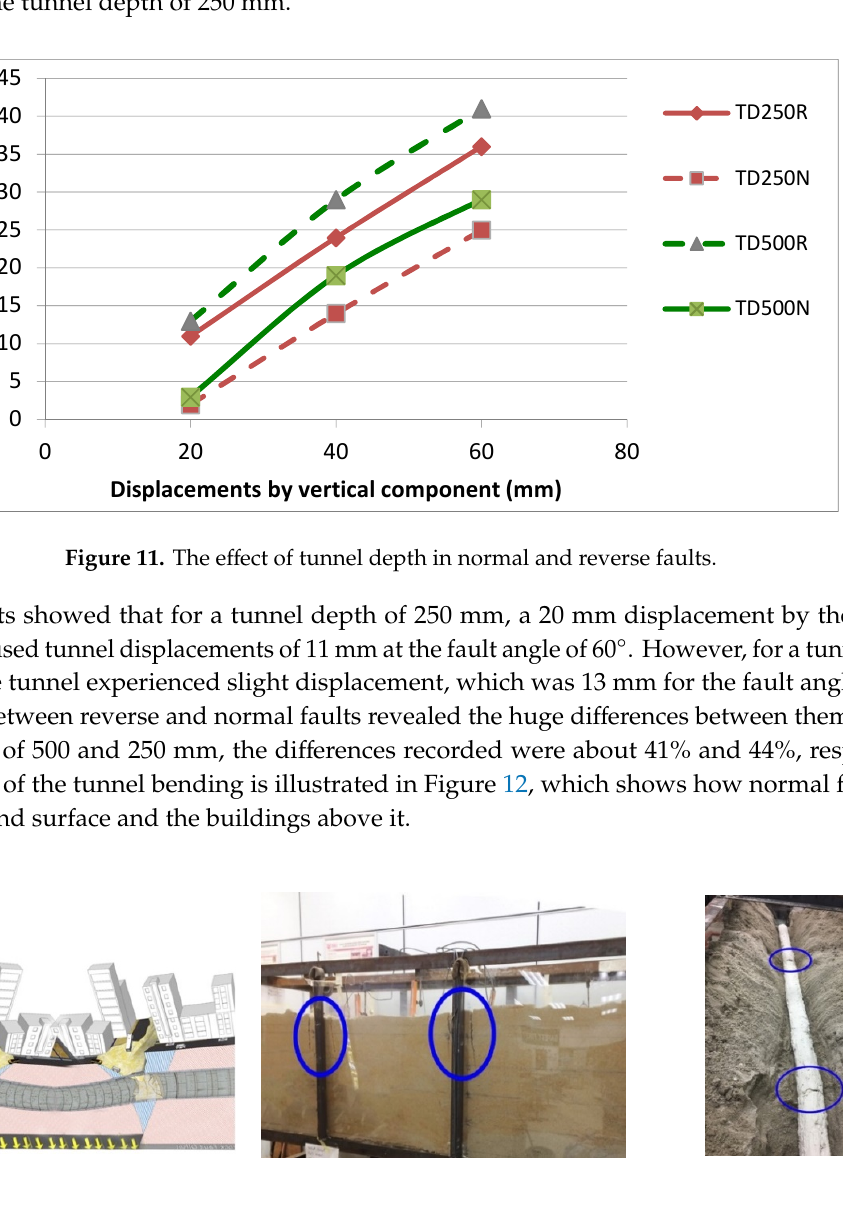
Displacements by vertical component (mm) Soft soil, Normal Fault Soft soil, Reverse Fault Rock, Reverse Fault Rock, Normal Fault